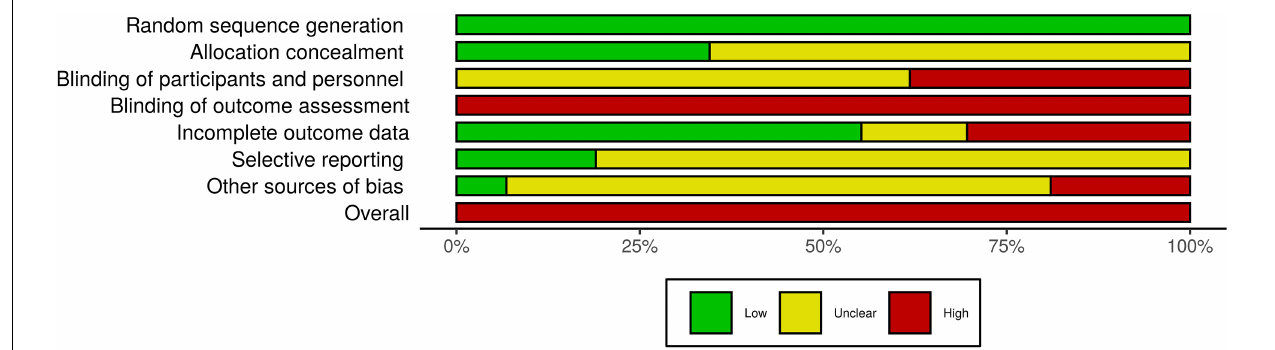
FIGURE 3 | Risk of bias for all